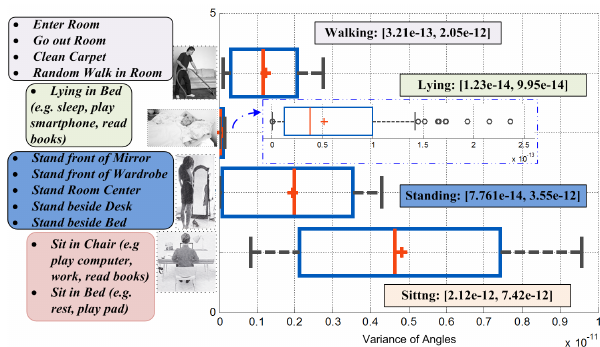
Figure 12: Regular activity categories and bound-